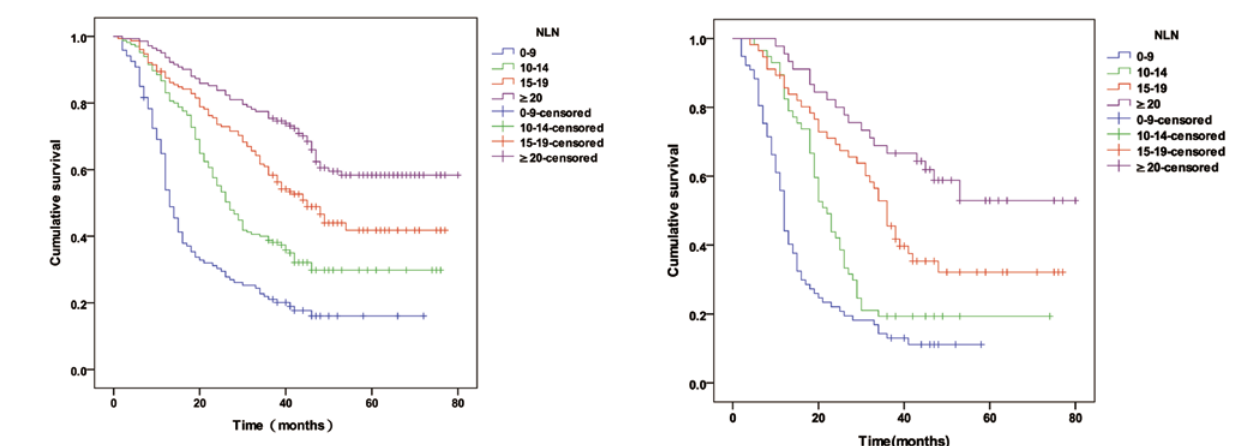
Figure 3: The overall survival curve for node-positive patients with 9 or less, 10 to 14, 15 to 19 and 20 or more NLNs